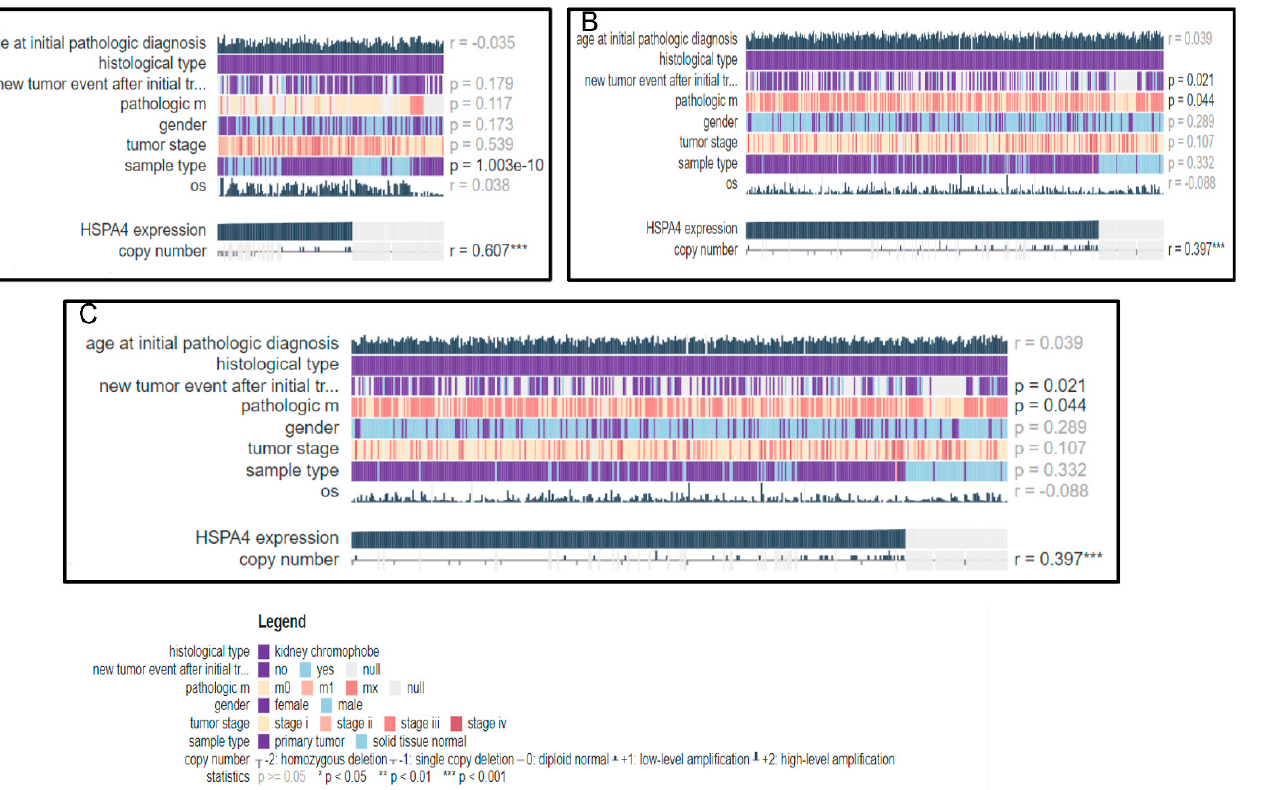
Figure 8. Observation of the MEXPRESS database for HSP70 in renal cell carcinoma (RCC). ( A ) Kidney chromophobe (KICH) subtype, ( B ) Kidney renal clear cell (KIRC) subtype, and ( C ) Kidney renal papillary carcinoma (KIRP) subtype. * p < 0.05, ** p < 0.01, *** p < 0.001.